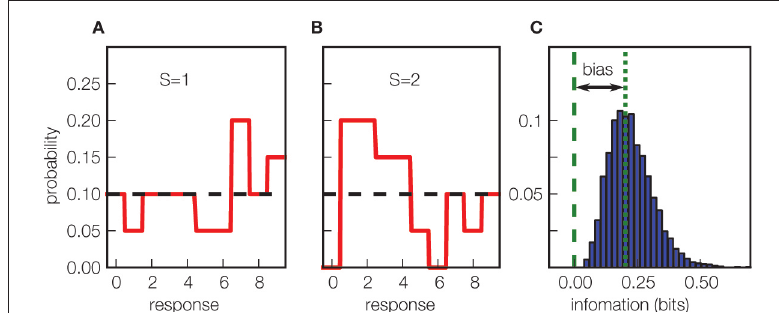
Figure 1 | The origin of the limited sampling bias in information measures. (A, B) Simulation of a toy uninformative neuron, responding on each trial with a uniform distribution of spike counts ranging from 0 to 9, regardless of which of two stimuli ( S = 1 in (A) and S = 2 in (B) ) are presented. The black dotted horizontal line is the true response distribution, solid red lines are estimates sampled from 40 trials. The limited sampling causes the appearance of spurious differences in the two estimated conditional response distributions, leading to an artificial positive value of mutual information. (C) The distribution (over 5000 simulations) of the mutual information values obtained (without using any bias correction) estimating Eq. 1 from the stimulus–response probabilities computed with 40 trials. The dashed green vertical line indicates the true value of the mutual information carried by the simulated system (which equals 0 bits); the difference between this and the mean observed value (dotted green line) is the